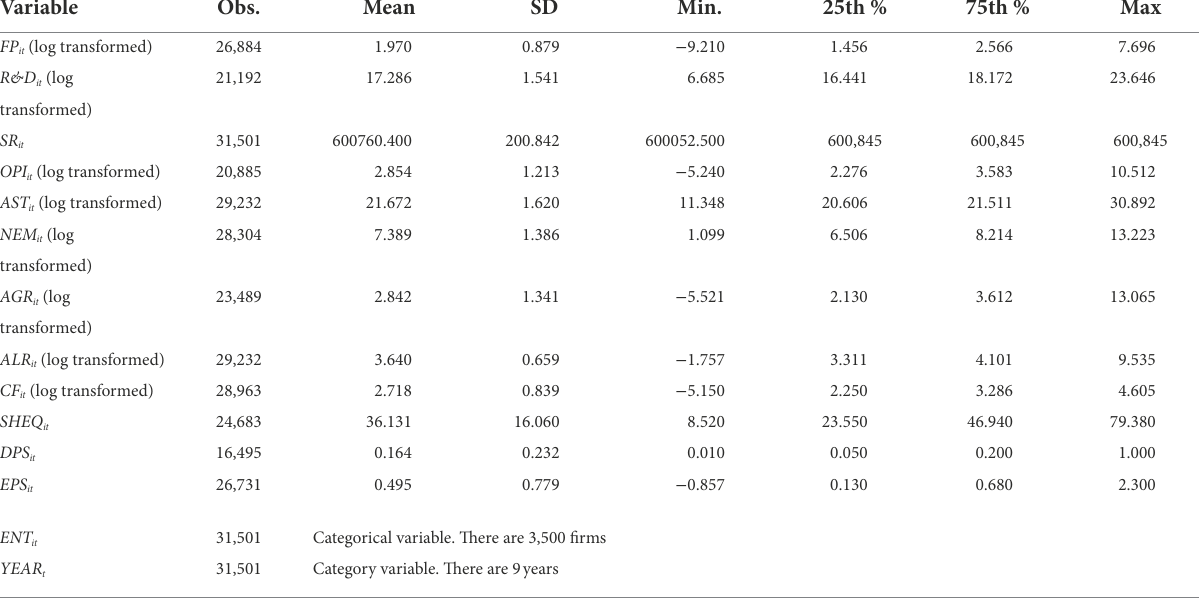
TABLE 1 Descriptive statistics.